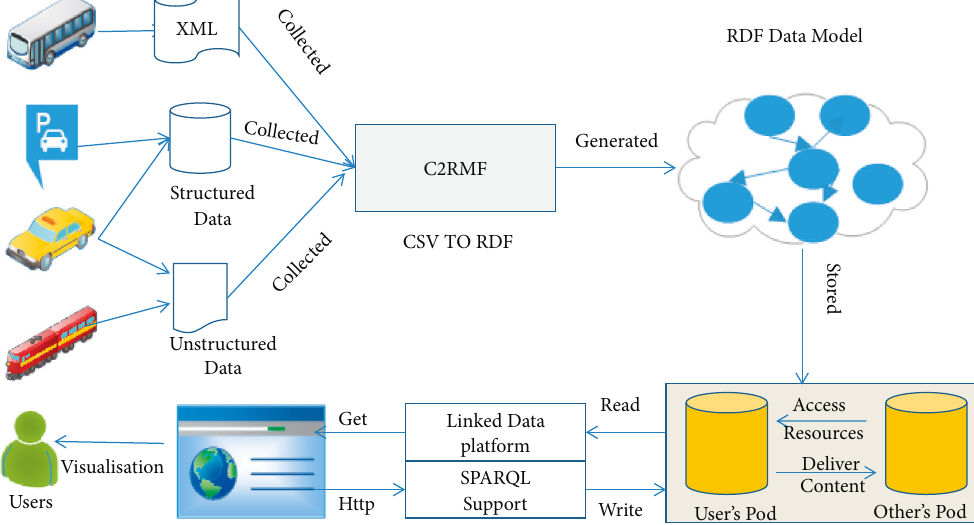
Figure 3: System framework.